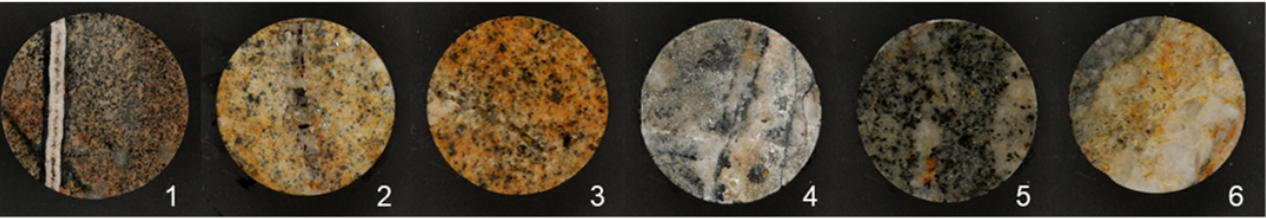
Figure 2. Top view on representative cores (40 mm diameter) from the six samples; the mineralogical composition of the sample and the veins is given in Table 1.